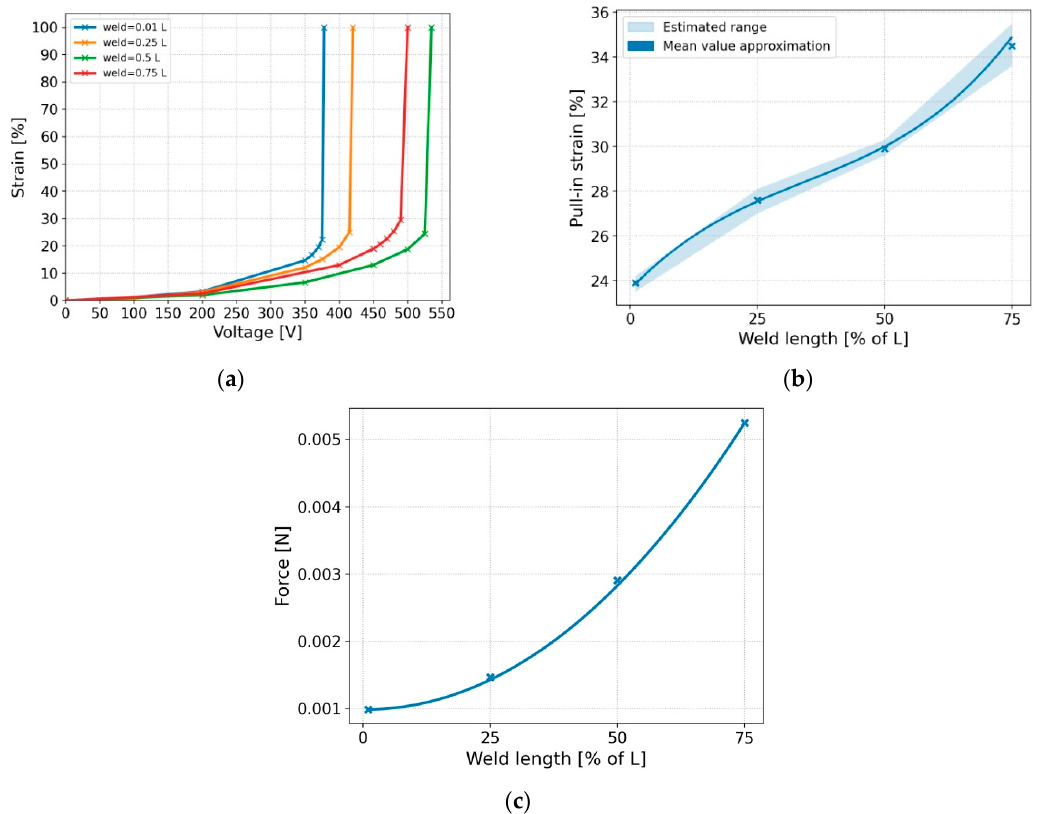
Figure 9. ( a ) Strain-voltage characteristics for 4 weld lengths of the actuator; ( b ) Pull-in strain-weld length characteristic of the actuator; ( c ) Force-weld length characteristic of the actuator.